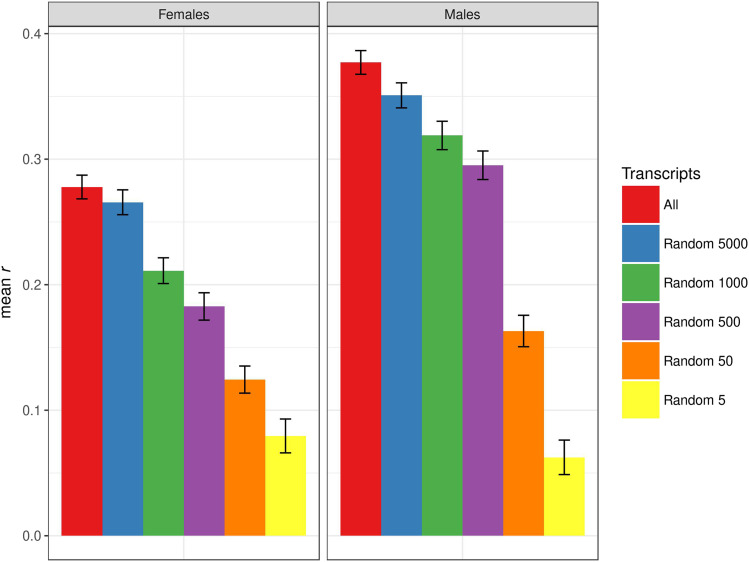
Prediction accuracy for starvation resistance, measured as mean r (on the y-axis) in the test set, obtained by using only different numbers of randomly selected genes in the TBLUP model. The bars represent the standard error of the mean. The left panel represents females, and the right panel represents males.